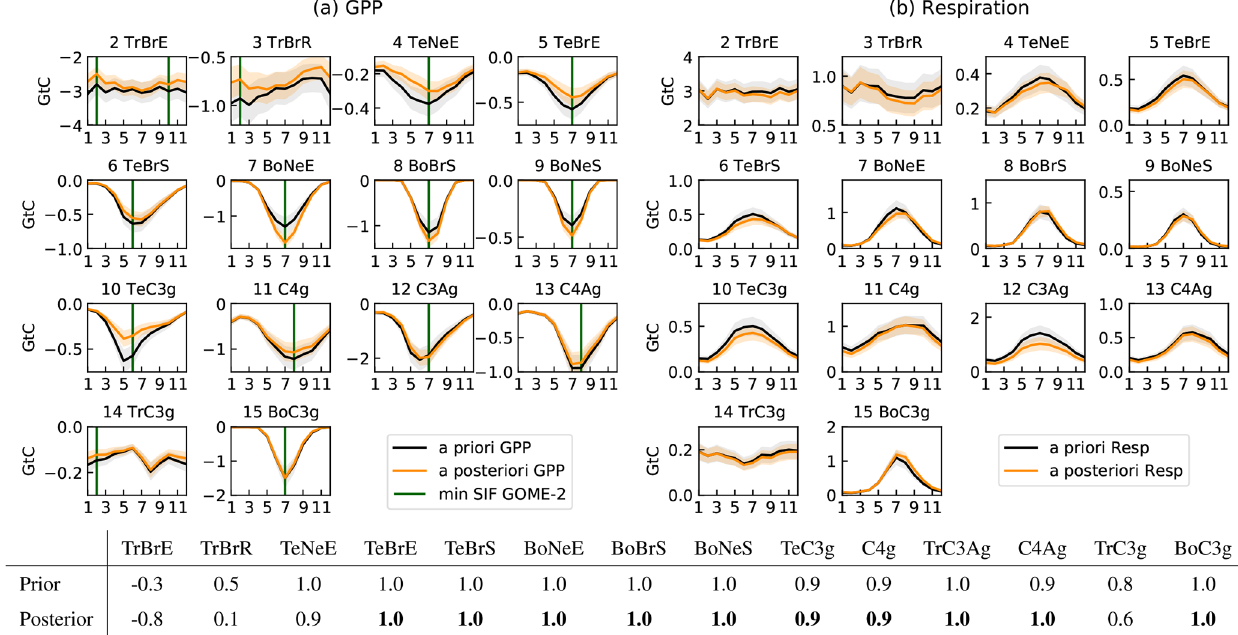
Figure 8. Mean seasonal cycle of the total prior (black) and posterior (orange) GPP (a) and respiration (a) fluxes and their uncertainties within each of the 15 PFTs during the period 2009–2018. The maximum of the mean seasonal cycle of the SIF from GOME-2 has been superimposed on the GPP seasonal cycle in green. The fluxes have been averaged over 2009–2018. Below are the correlation coefficient between the monthly SIF an the GPP averaged during the period 2009–2018. The values in bold indicate the PFTs with a GPP improved or unchanged by the inversion. PFT 1, bare soil, is not shown as respiration, and GPP is null. Only the values integrated over the Northern Hemisphere are shown for PFTs 4, 5, 6, 10, 11, 12 and 13. The identifiers of the PFTs are described in Appendix A. The abbreviations Tr, Bo and Te mean tropical, boreal and temperate,